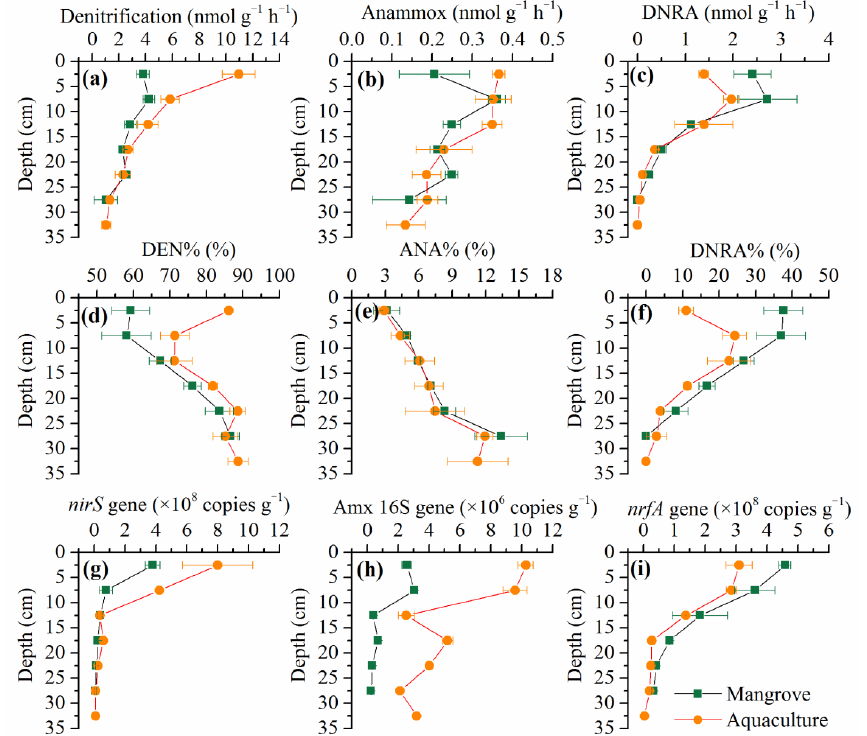
Figure 2. Denitrification, anammox, and DNRA rates ( a ) – ( c ) and their contributions to the total NO x − removal rates (DEN%, ANA%, and DNRA%; ( d ) – ( f ) and related gene abundance ( nirS , Amx 16S NO x − removal rates (DEN%, ANA%, and DNRA%; ( d – f ) and related gene abundance ( nirS , rRNA, and nrfA ; ( g ) – ( i ) in mangrove and aquaculture sediment cores. The error bars represent standard deviations.